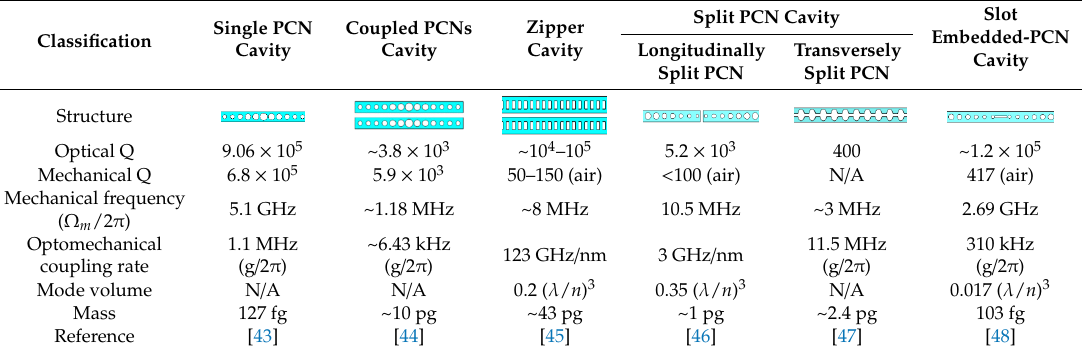
Table 1. Typical configurations of 1D PhC cavities for opto-mechanical interactions.